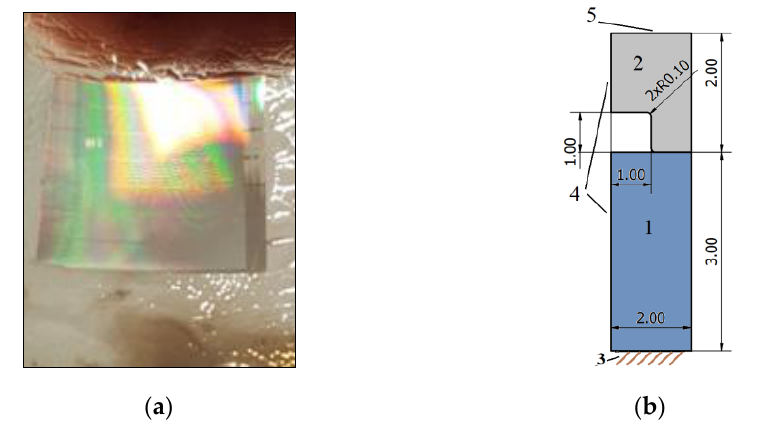
Figure 5. ( a ) Template of nickel master grating plate; ( b ) drawing of one master-grating element with boundary conditions: 1 — substrate, 2 — stamp, 3 — fixed support, 4 — symmetry region and 5 — an external force.